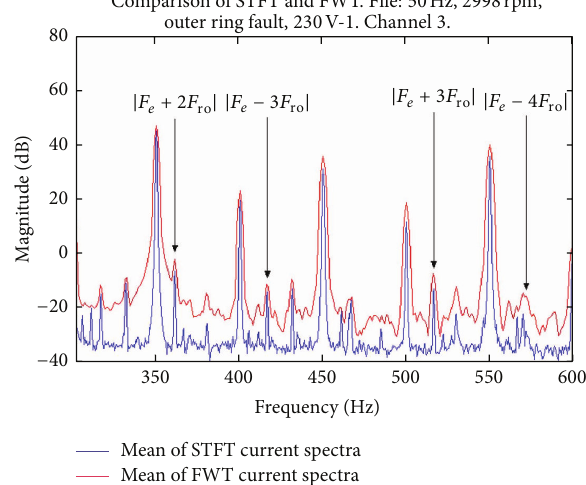
Figure16:ComparisonofFWTandSTFTcurrentanalysisfor50 Hz input, pump load, outer raceway fault, and current